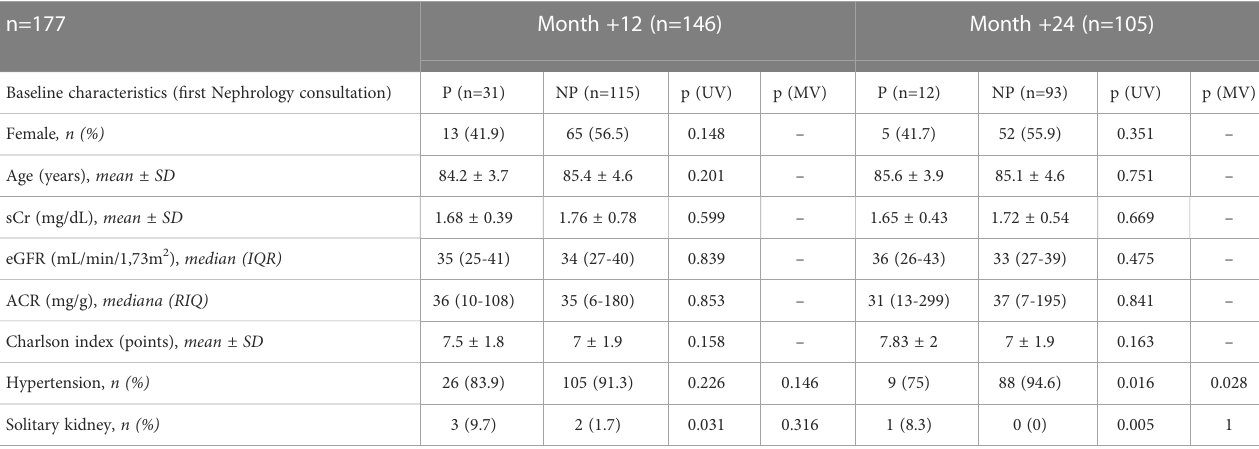
TABLE 5 Progression related factors after 12 and 24 months in initial